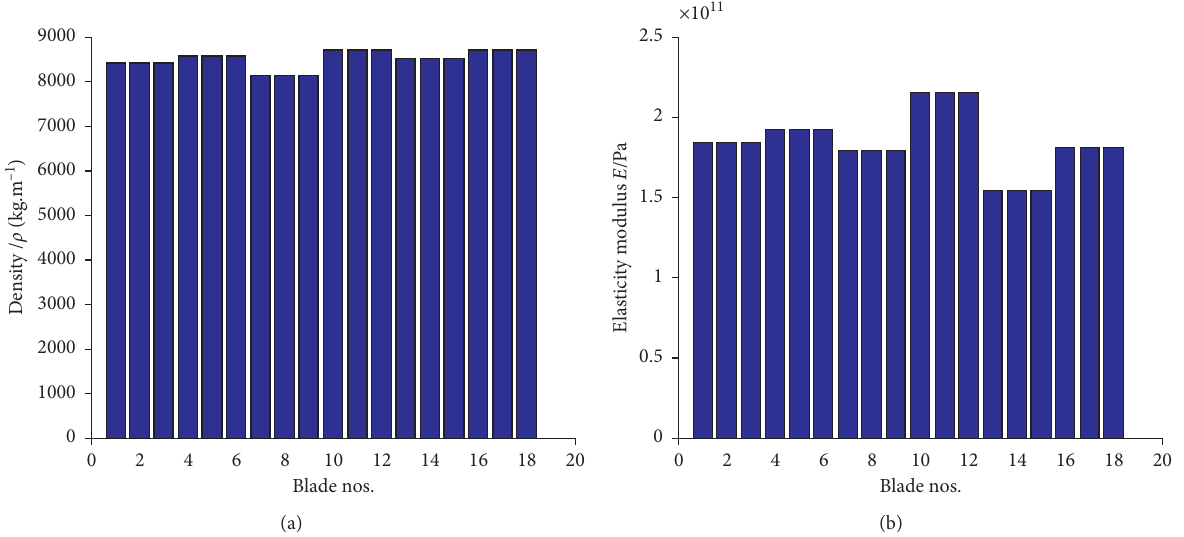
Figure 12: Intentionally mistuned design. (a) Density of blades. (b) Elastic modulus of